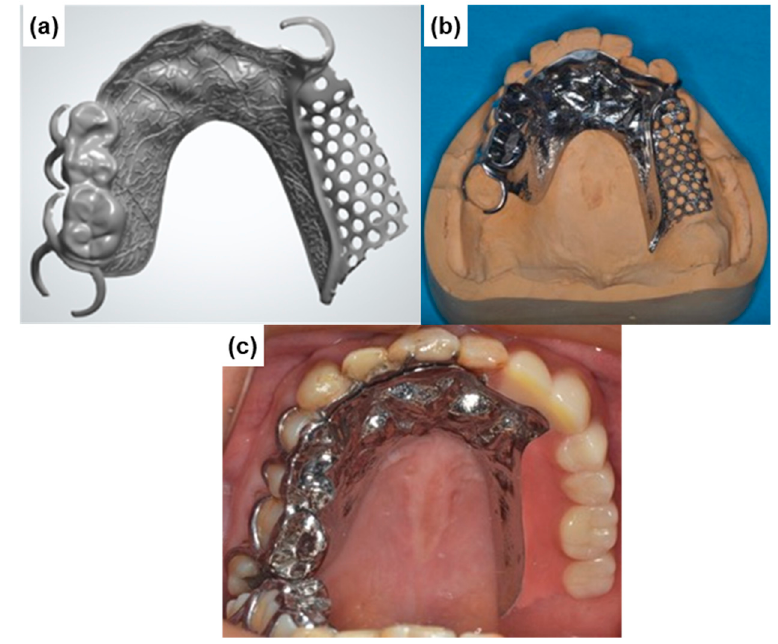
Figure 13. Partial dentures manufactured by laser sintering with CP Ti G 2 powder. ( a ) laser-sintered metal frame; ( b ) polished metal frame; ( c ) partial denture.